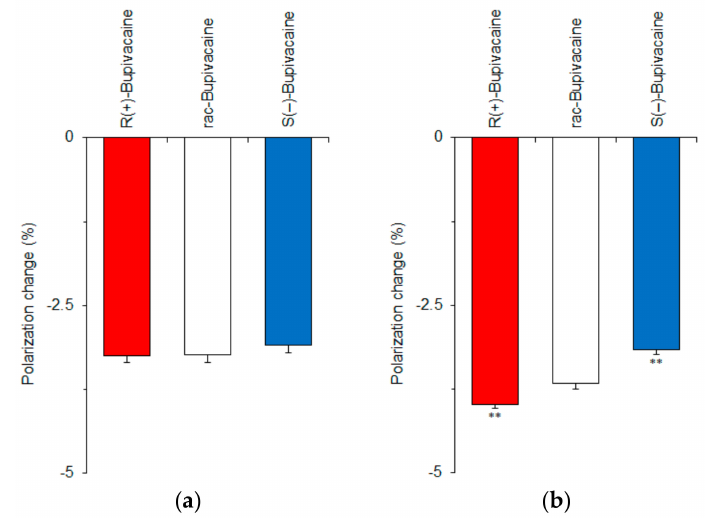
Figure 3. Interactions of bupivacaine stereoisomers (50 µ M for each) with neuro-mimetic membranes in the absence ( a ) or presence ( b ) of 10 mol % cholesterol. ** p <0.01 compared with rac